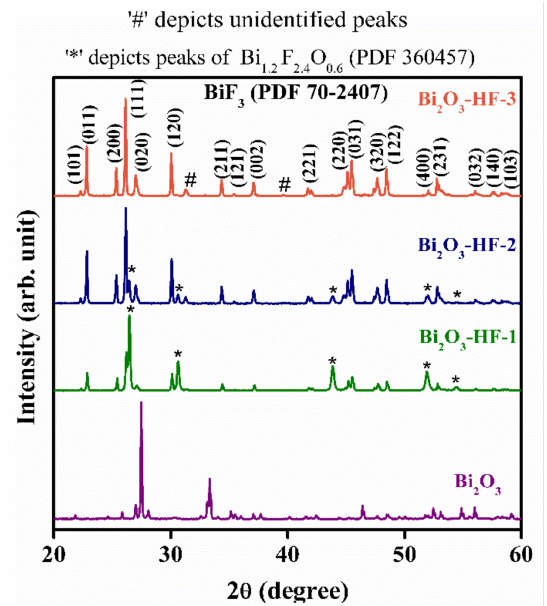
Figure 1. X-ray diffraction patterns of purchased Bi 2 O 3 and Bi 2 O 3 after three successive HF treat- ments depicted as Bi 2 O 3 -HF-1, Bi 2 O 3 -HF-2, Bi 2 O 3 -HF-3, and Bi 2 O 3 -HF-4,